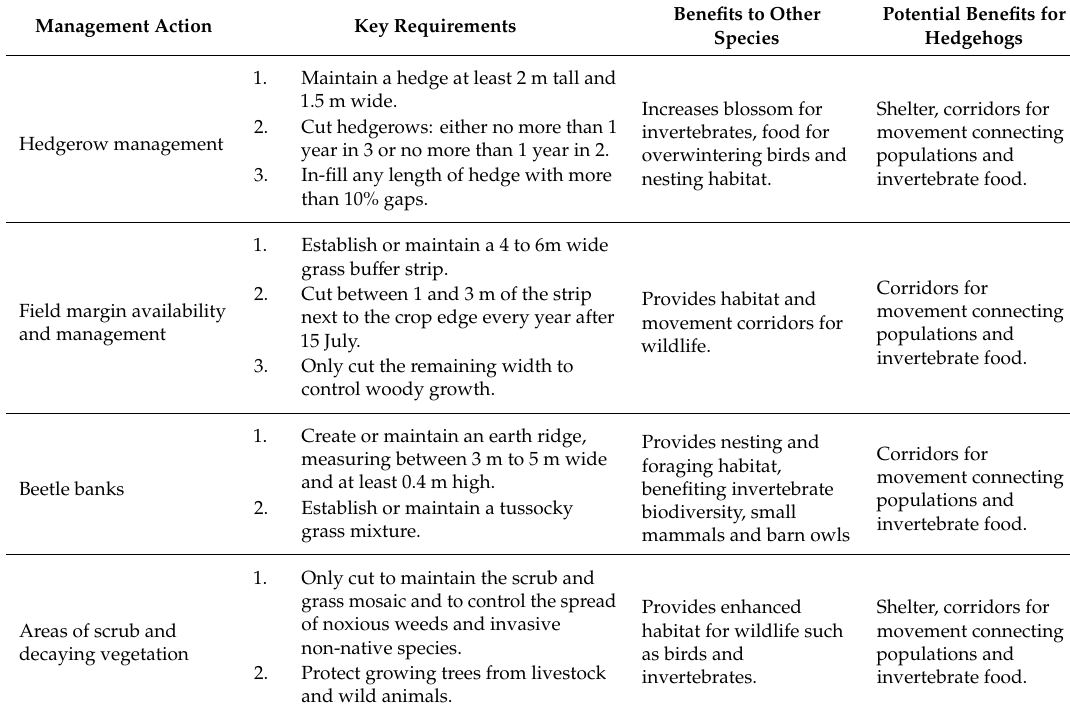
Table 1. Summary of agri-environment management options that benefit biodiversity and are likely to be of benefit to hedgehogs ( Erinaceus europaeus ) in agriculturally dominated landscapes in the United